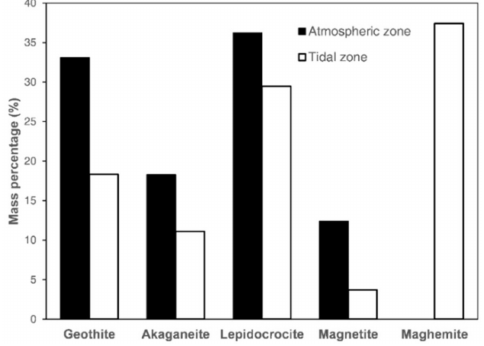
Figure 14. Mass fractions of rust phases by